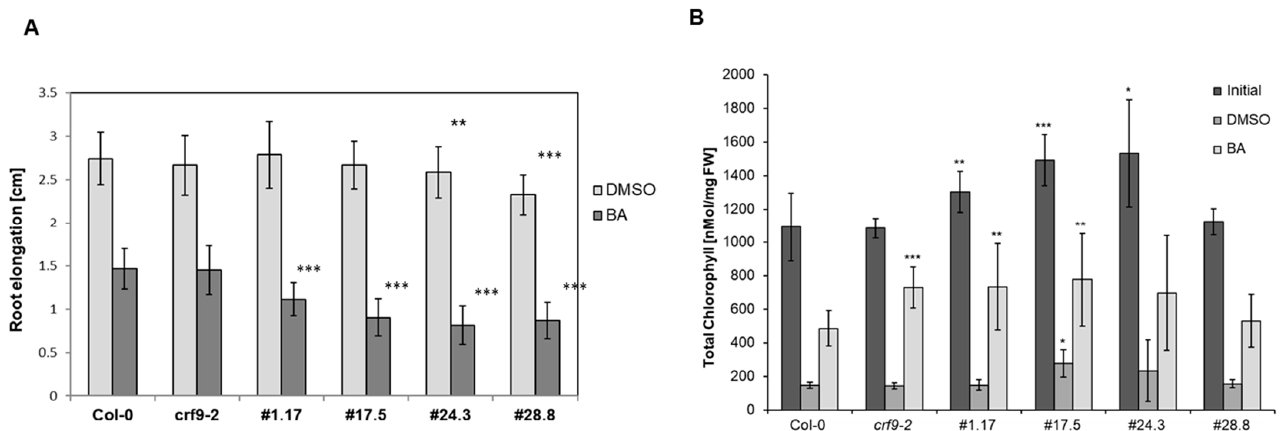
Figure 8. CRF9 overexpression leads to attenuation of cytokinin effect in roots. The effect of CRF9 overexpression was tested in two different long-term cytokinin response assays. ( A ) Plants of the different lines investigated were grown on 0.5 × MS-media containing 100 nM benzyl adenine (BA) under long-day conditions in a growth chamber. DMSO was used as a solvent control. The tip of the primary root was marked on the third and tenth day after germination and the root elongation was determined using ImageJ (www.imagej.nih.gov/ij/, accessed on 21 December 2022). ( B ) The sixth leaves of the respective plants was taken and incubated for six days in the dark with 1 µM BA or DMSO as solvent control. After the sixth day, the chlorophyll of the dark-incubated leaves and those of untreated leaves was extracted and measured ( n = 12 Level of significance in a one-sided t -test: * = p < 0.05, ** = p < 0.01, *** = p < 0.001.